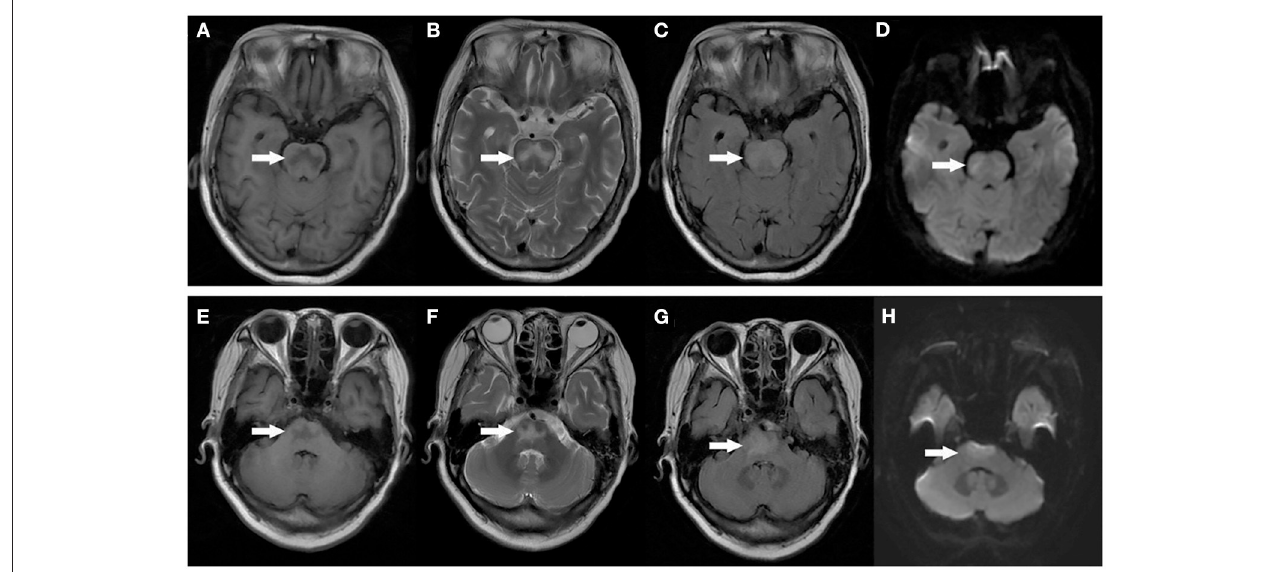
FIGURE 4 | MRI image of the patient’s head: Axial T1 weighted images demonstrating symmetric low signal in the central pons (A,E) . Axial T2 weighted images demonstrating symmetric high signal in the central pons (B,F) . T2 FLAIR images demonstrate symmetric high signal in the central pons (C,G) . DWI images didn’t show any diffusion restriction in the central pons (D,H)